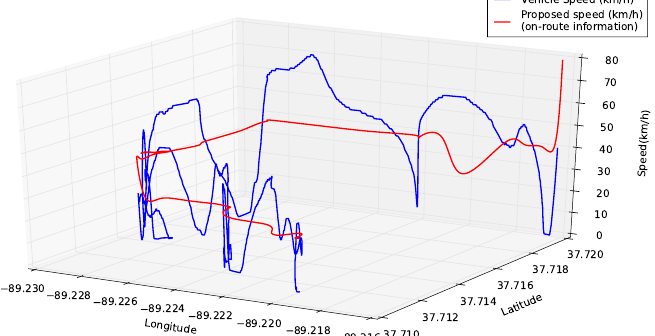
Figure 5. On-route based speed